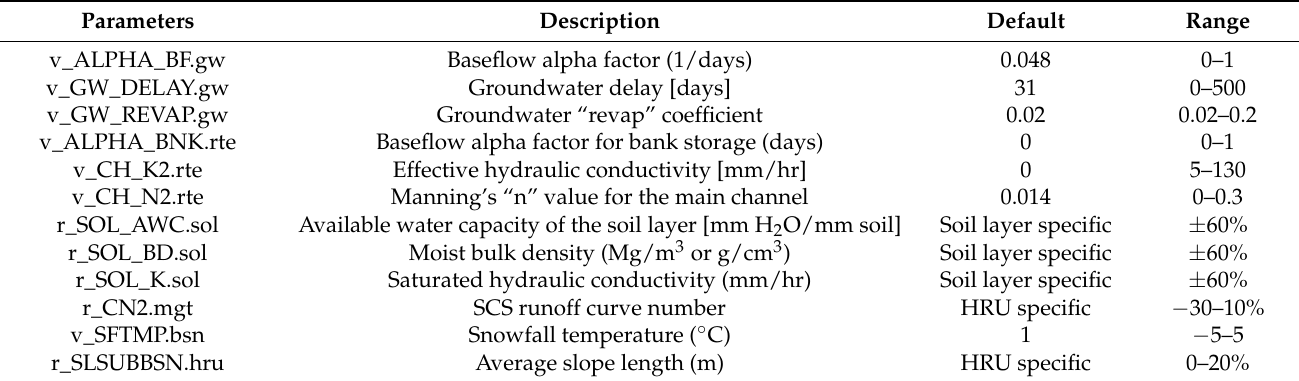
Table 1. List of parameters used for calibration and their default values and ranges for calibration (“a__”, “v__”, and “r__” mean an absolute increase, a replacement, and a relative change from the initial parameter values,